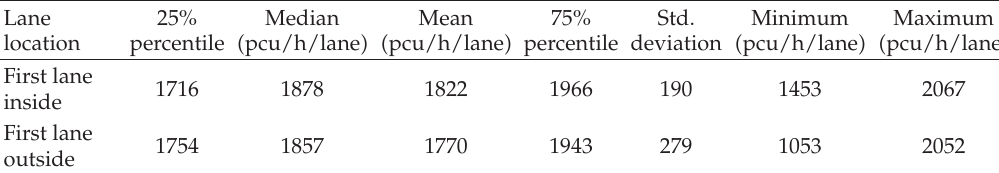
Table 4: The statistics of flow rate before breakdown.